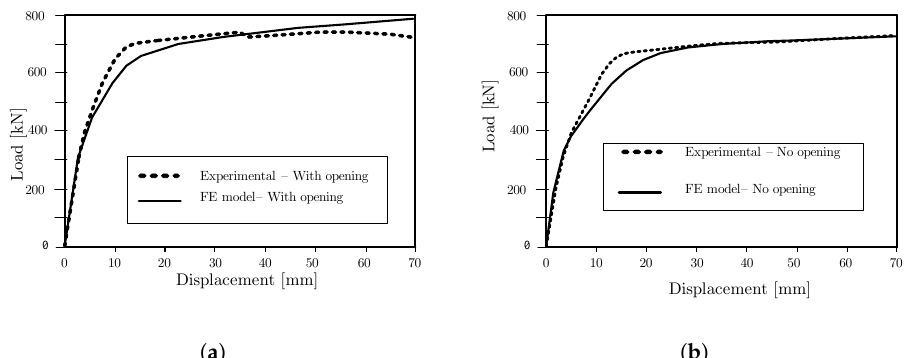
Figure 2. The load–displacement curves of experimental and numerical models, ( a ) with opening, and ( b ) without opening.